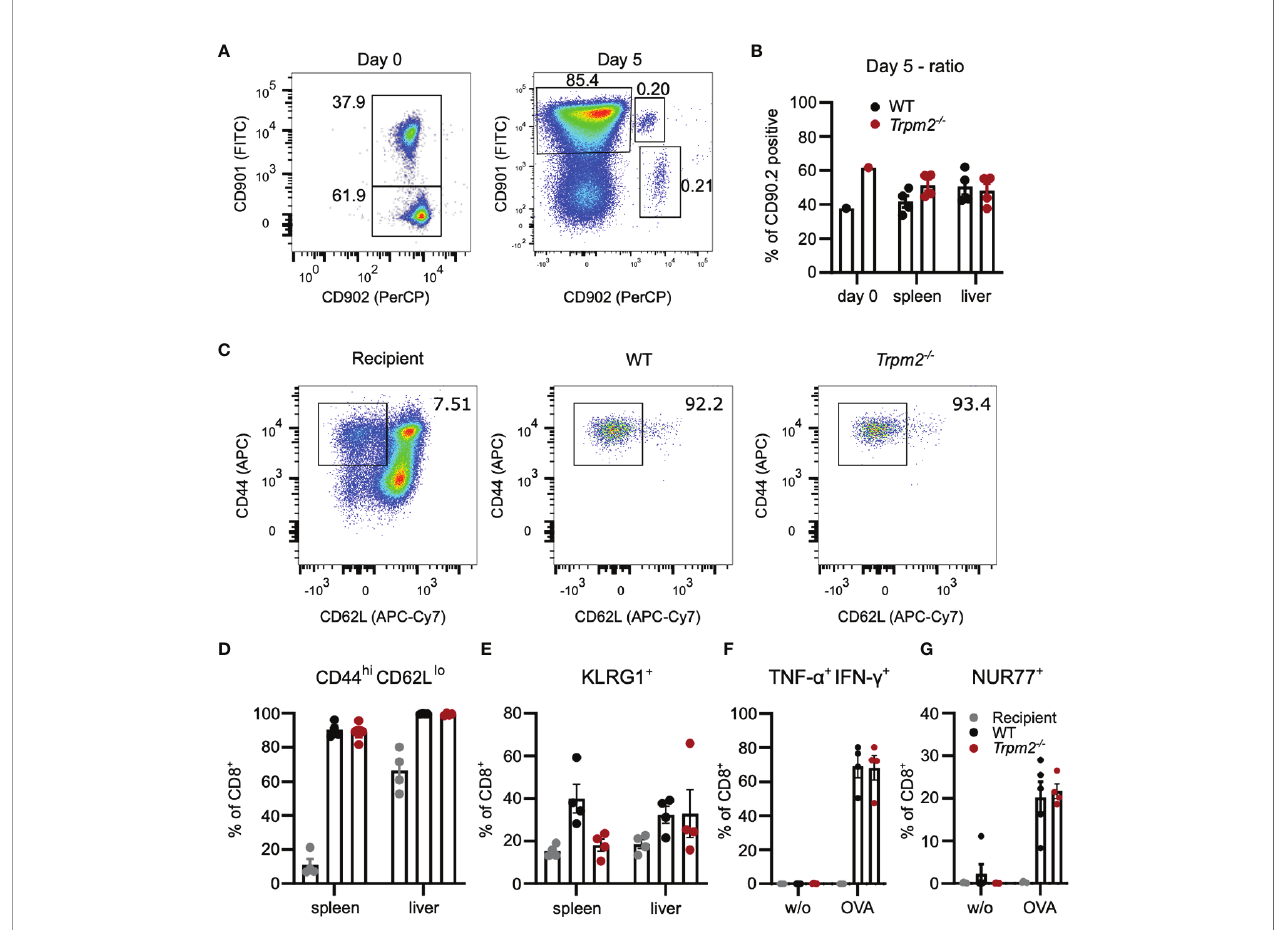
FIGURE 4 | TRPM2 de fi ciency does not impair the acute CD8 + T-cell response to L. monocytogenes in a T-cell transfer model. Trpm2 -/- CD8 + OT-1 T cells (CD90.1 - CD90.2 + ) and WT CD8 + OT-1 T cells (CD90.1 + CD90.2 + ) were mixed roughly at a ratio 1:1 and 10 4 CD8 + T cells were i.v. transferred to CD90.1 + CD90.2 - WT mice. Recipients were infected on the same day with LmOVA and analyzed 5 days later. (A) Representative dot plots for CD90.1 and CD90.2 staining of the transferred CD8 + T-cell population (Day 0) and of the CD8 + T cells from the spleen at day 7. (In the experiment shown, we transferred cells with a 2:3 ratio of WT to Trpm2 -/- CD8 + T cells.) (B) Frequencies of WT and Trpm2 -/- cells among CD8 + donor T cells at day 0 (mix before transfer) and day 5 postinfection. (C) Representative dot plots for CD44 and CD62L expression of donor and recipient CD8 + T cells. (D) Frequencies of CD44 hi CD62L lo donor and recipient CD8 + T cells in spleen and liver. (E) Frequencies of KLRG1 + donor and recipient CD8 + T cells in spleen and liver. (F) Spleen cells were stimulated for 4 h with OVA 257-264 peptide and the frequencies of IFN- g + TNF- a + donor and recipient CD8 + T cells was determined by intracellular cytokine staining. (G) Frequencies of NUR77 + donor and recipient CD8 + T cells after OVA 257-264 peptide stimulation of spleen cells. Bars give the mean ± SEM. Results in (D – G) and were analyzed with ANOVA with Dunnett ’ s multiple-comparison test. Experiments were conducted